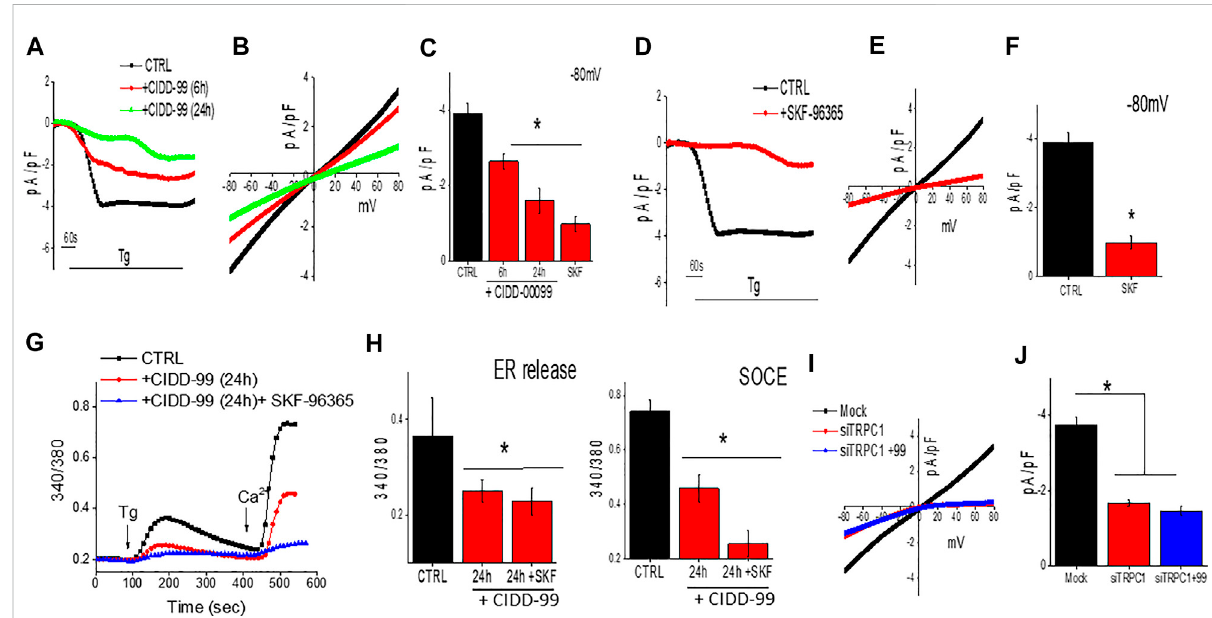
FIGURE 3 CellstreatedwithCIDD-99inactivateTRCP1channels. (A) Representativetracesshowinginwardcurrents(atholdingpotentialof-80 mV)upon application of Thapsigargin (2 µM) in the bath solution from Cal-27 cells and with CIDD-99 pretreated cells. (B) Relative IV curves (acquired when currentsreachpeak)areshown. (C) Quanti fi cationofcurrentdensityundertheseconditionsareshownfrom7 – 9cellsforeachcondition.*Indicates signi fi cantly different (using one-way ANOVA) from control p < 0.05. (D) Representativetracesshowing application Thapsigargin (2 µM)in bath solution induced inward currents with holding potential of -80 mV from Cal-27 cells and SKF-96365 (10 µM) pretreated cells. (E) Relative IV curves (acquired when currents reach peak) are shown. Quanti fi cation of current intensity (using one-way ANOVA, n = 10 – 12 cells) under these conditions areshownasbargraph (F) . (G) Fura2analogplots(340/380ratio)undervariousconditionsaslabeledweremeasured.Quanti fi cationof fl uorescence ratio (peak value) from 50 – 80 cells is shown as bar graph (H) * Indicates signi fi cantly different ( p < 0.05 using one-way ANOVA) from control untreated cells. Individual showing IV curves in controlsiRNA (Mock), TRPC1siRNA (siTRPC1) and TRPC1siRNA + CIDD-99 (I) . Quanti fi cation of current intensity (peak value) is shown as bar graph (J) . * Indicates signi fi cantlydifferent( p < 0.05 using one-way ANOVA) from control Mock treated